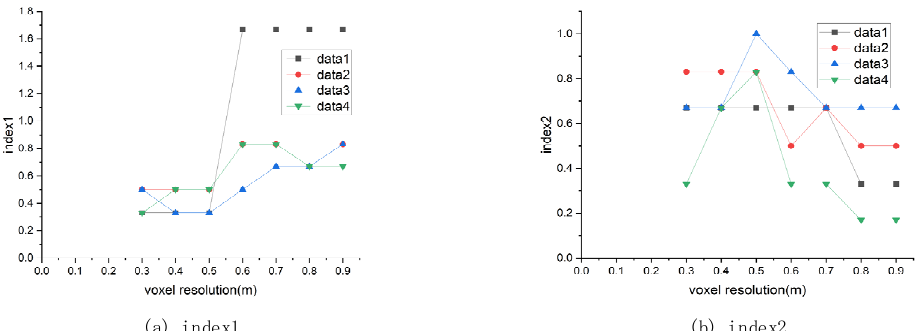
Figure 13. The effect of clustering grid resolution on the results.